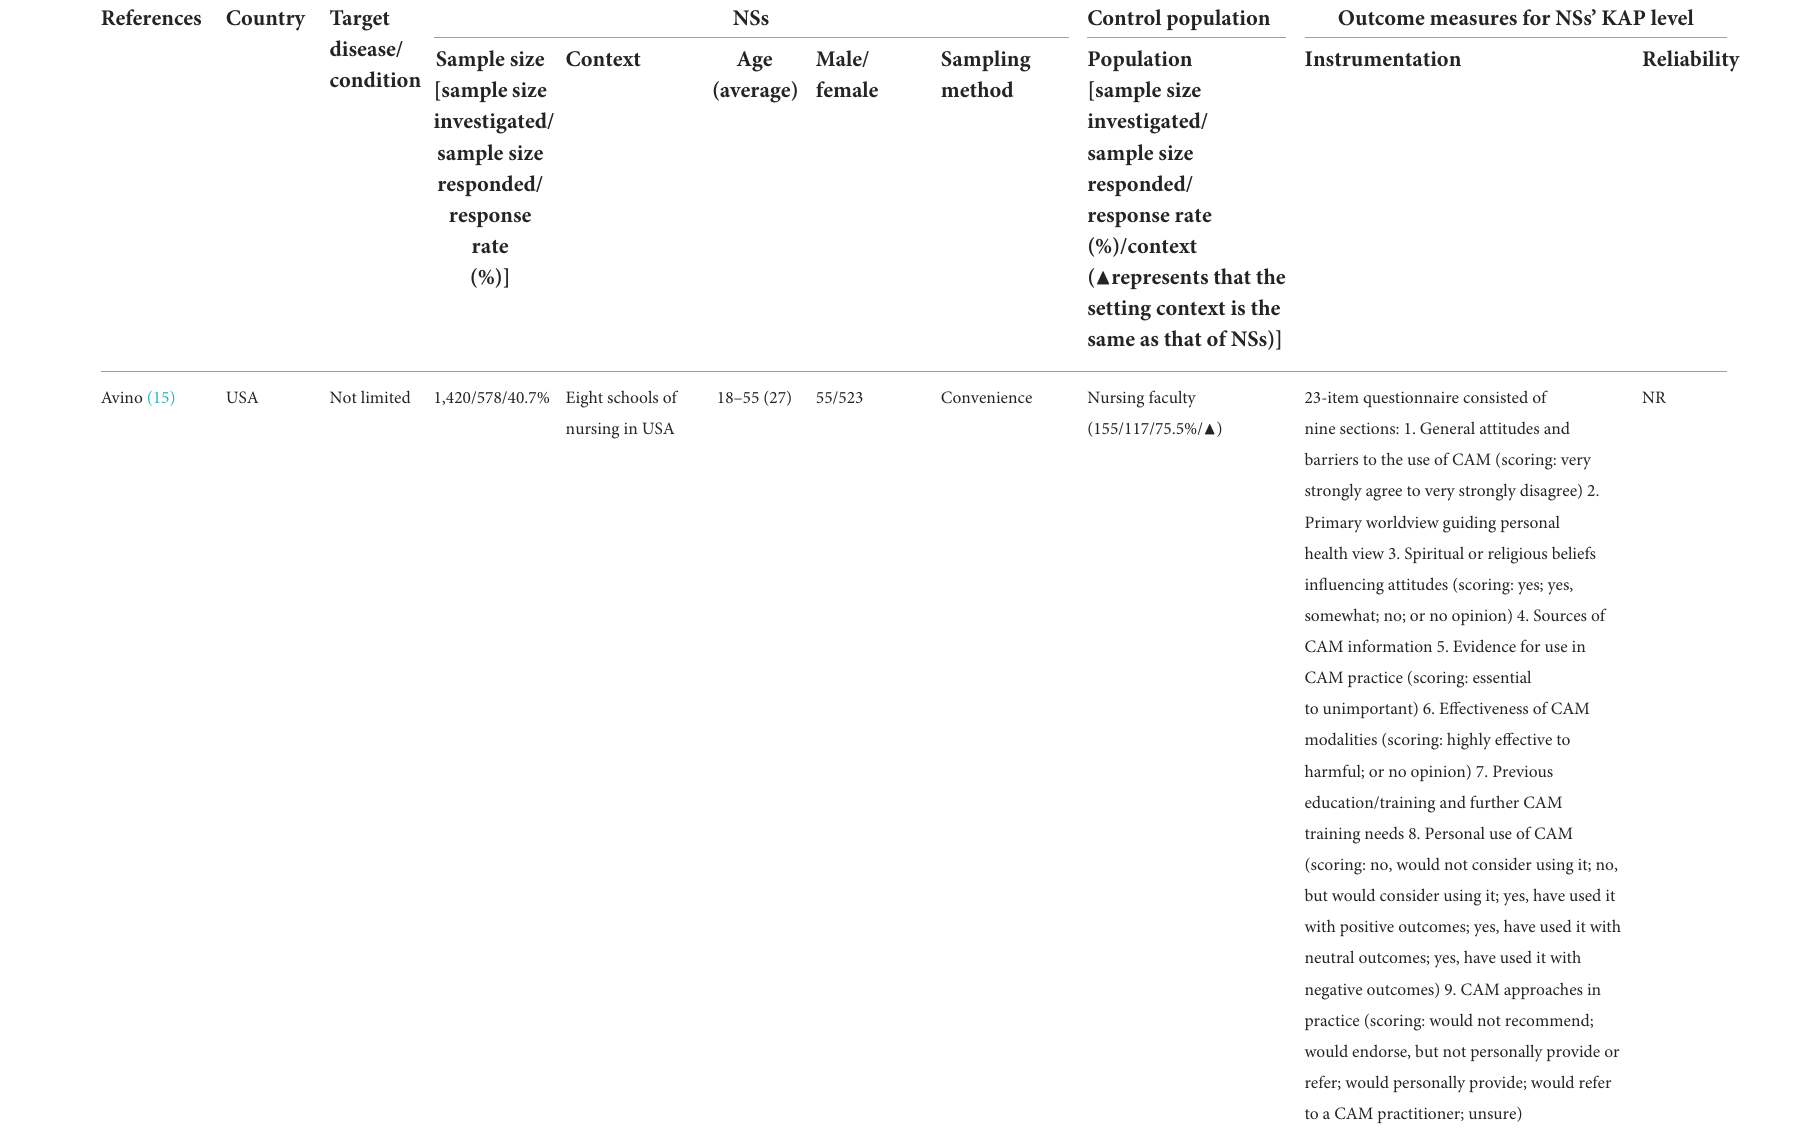
TABLE 1 Study characteristics and outcome measurement tools of 26 included